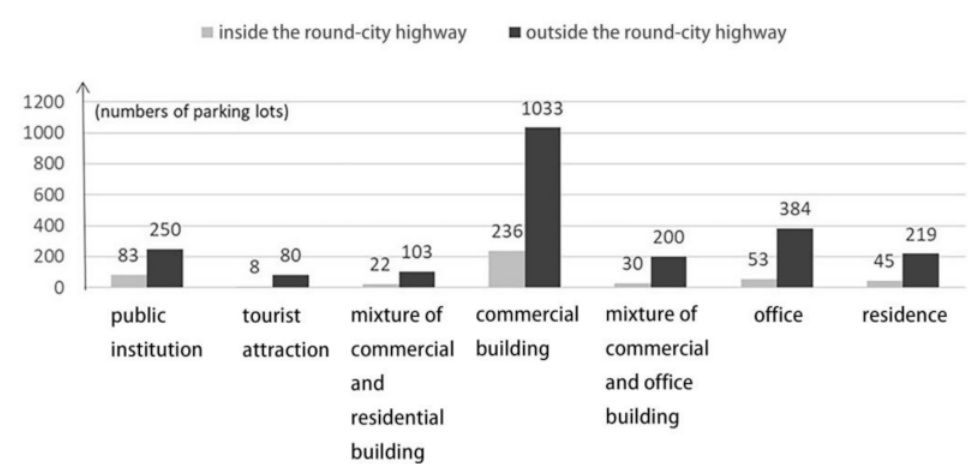
Figure 8. The kernel density of parking lots’ sizes.